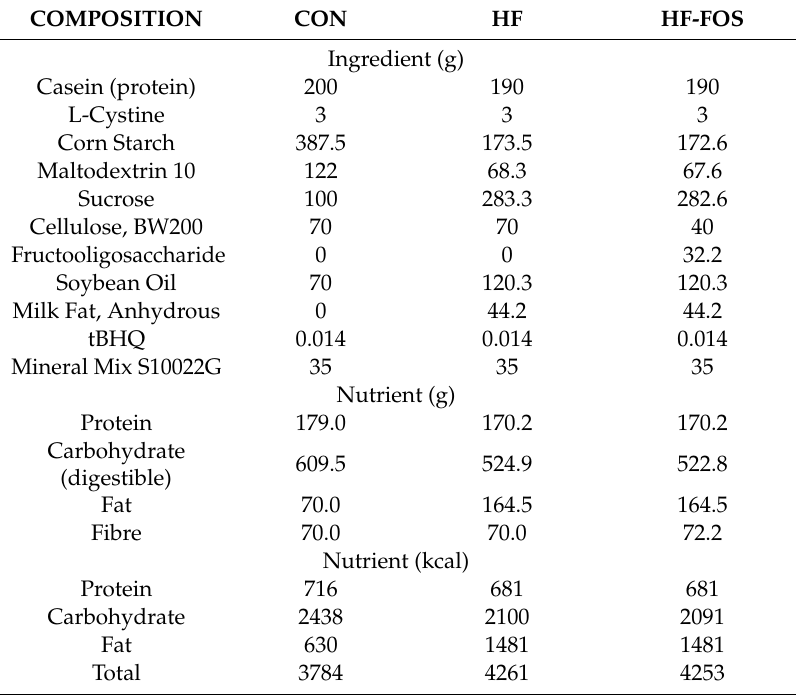
Table 1. Composition of the experimental diets (per 1000